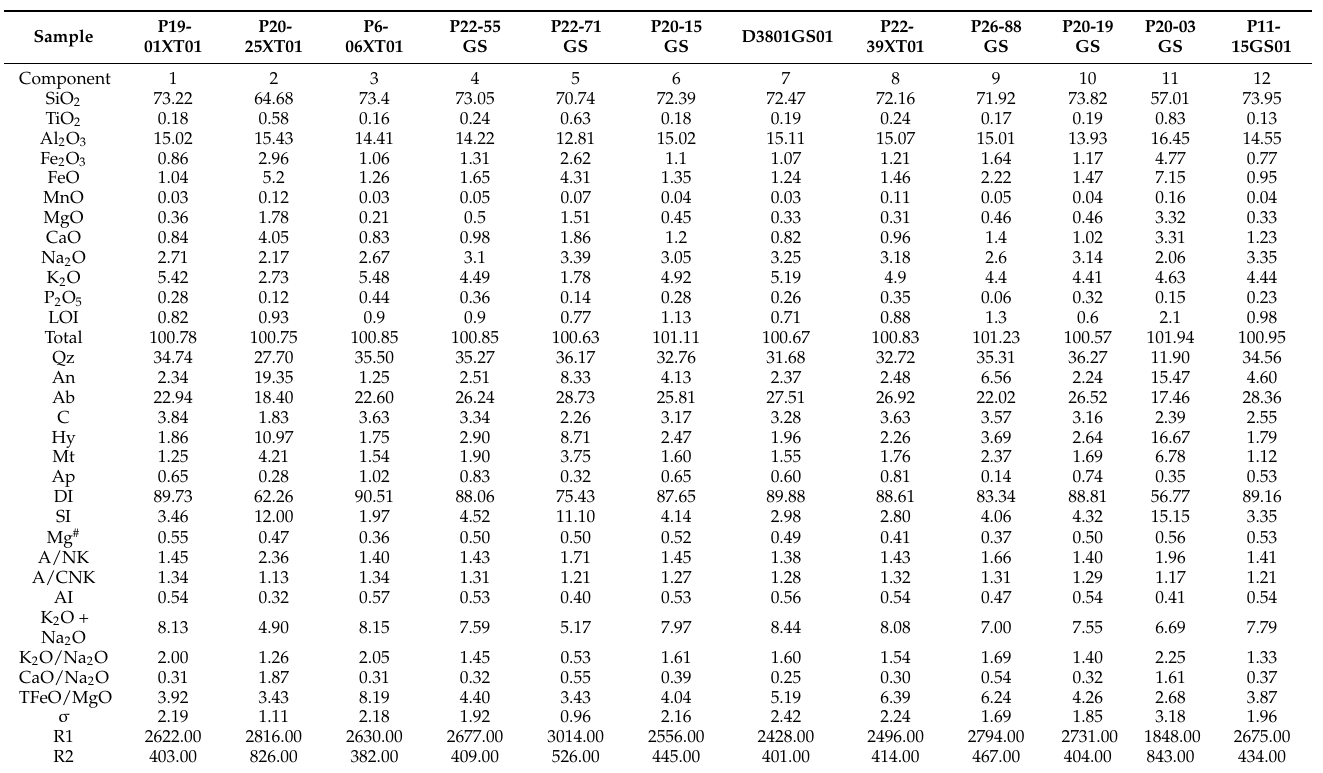
Table 1. Major element (wt.%) and CIPW norm (wt.%) contents of Dahongliutan granite